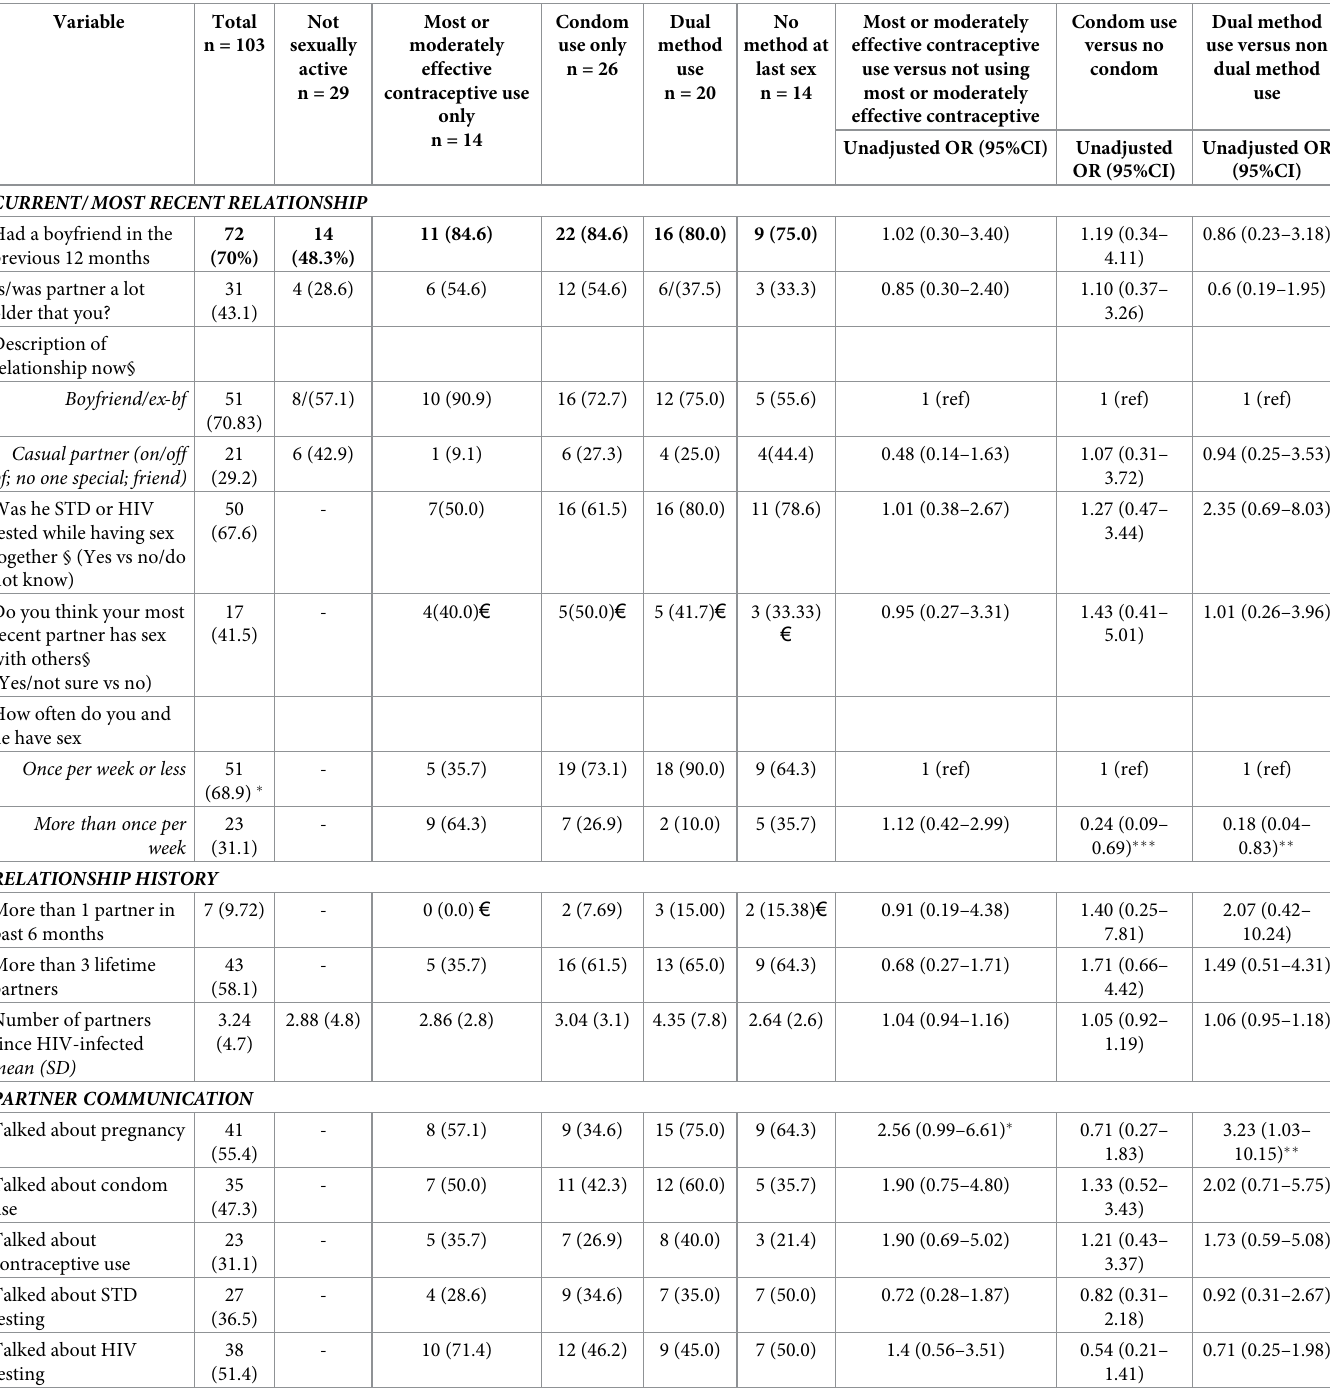
Table 2. Description of relationship-level factors among young HIV-infected study participants and association between these factors and most or moderately effective contraception use only, condom use only, and dual method use at last coitus.